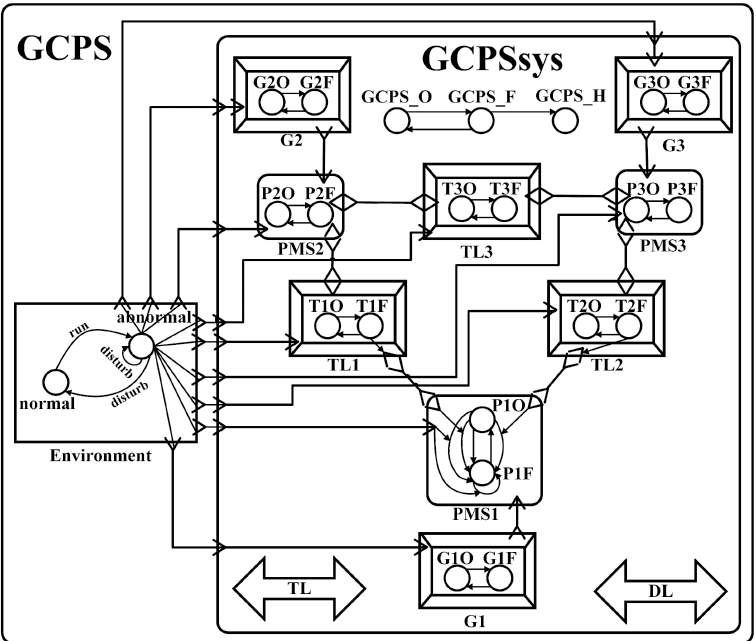
Figure 3. an AADL model of a GCPS with the